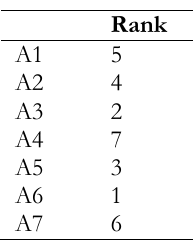
Table 28. Ranking